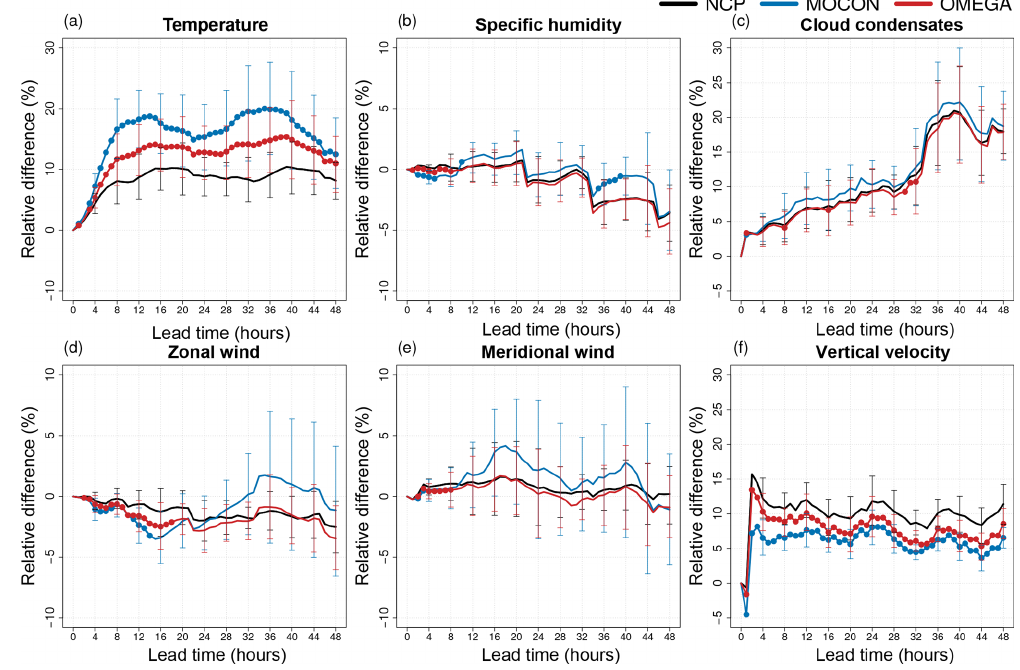
Figure 16. Same as Fig. 15 but for the 850hPa